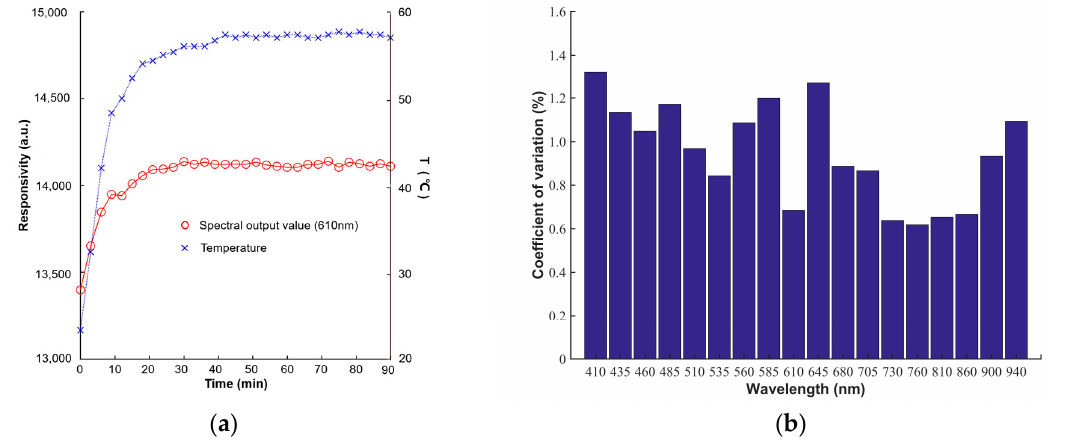
Figure 4. ( a ) Temperature and spectral output value of the multispectral system in 90 min; ( b ) coefficient of variation of 50 output values of multispectral system after preheating.